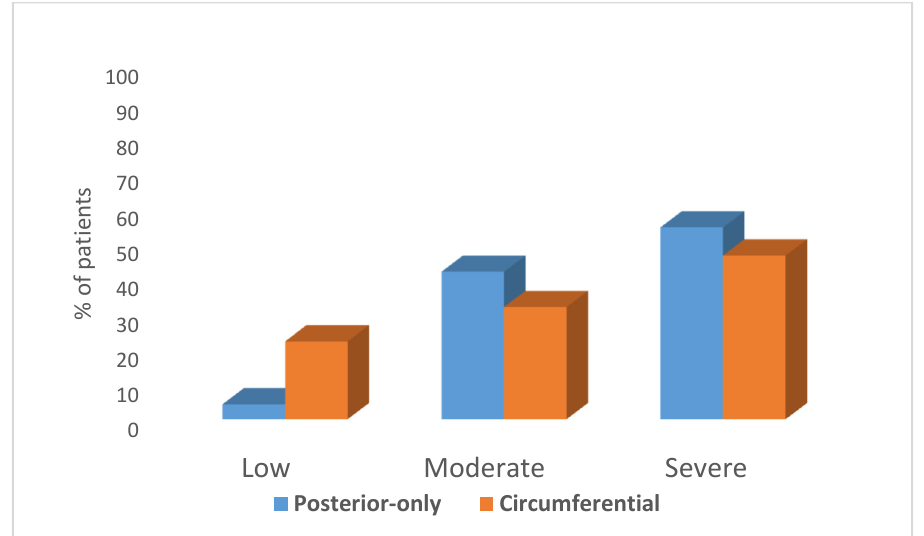
Figure 2. Degrees of pelvic floor hypertonicity according to vestibular tenderness location. Percentage of women with mild, moderate and severe degrees of hypertonicity, according to vestibular tenderness location (circumferential or posterior-only). Those with Posterior-only vestibular tenderness had a higher incidence of moderate and severe hypertonicity in comparison to those with Circumferential vestibular tenderness.